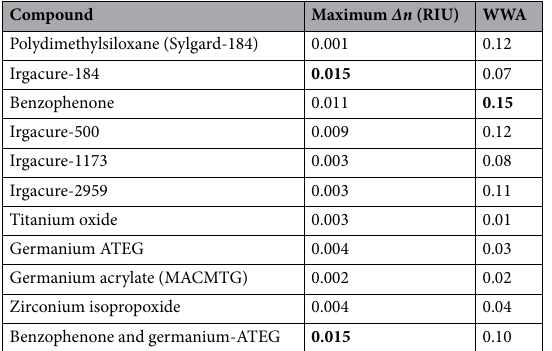
Compound Maximum Δn (RIU) WWA Polydimethylsiloxane (Sylgard-184)